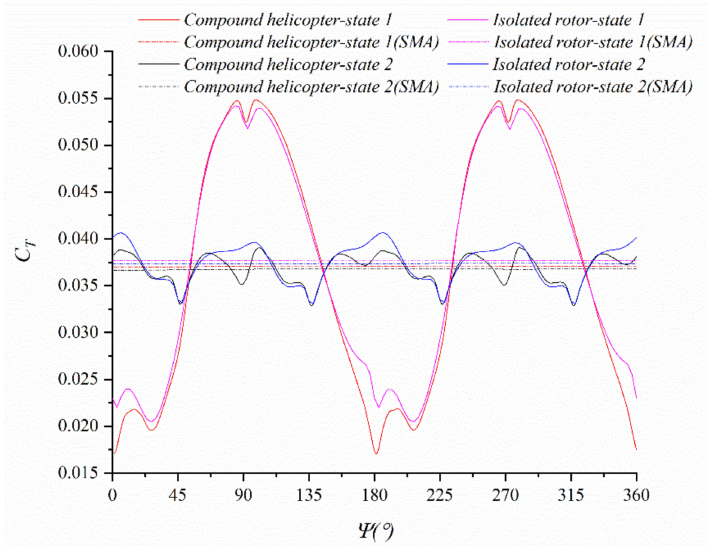
Figure 30. The compound coaxial helicopter lower rotor C T in forward flight.